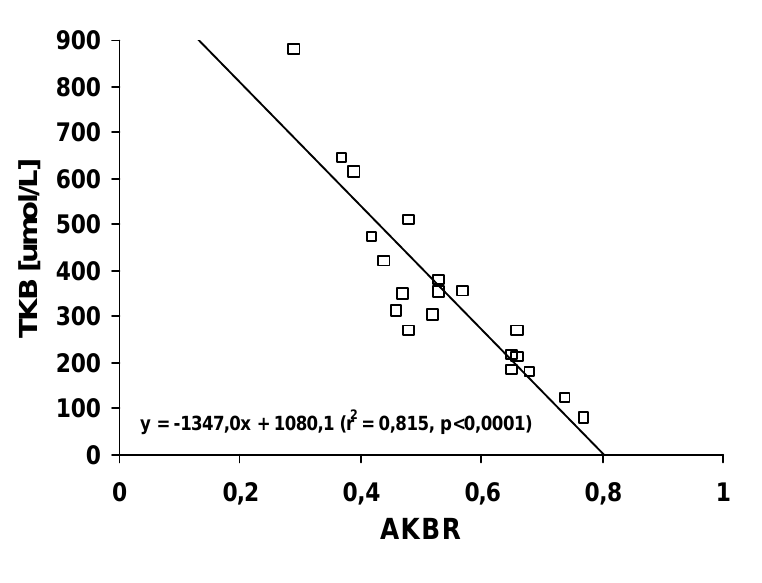
Figure 3. The relationship between total ketone body concentration (TKB) and arterial ketone body ratio (AKBR) in patients with Carcinoma hepatis metastaticum and good circulatory condition (group